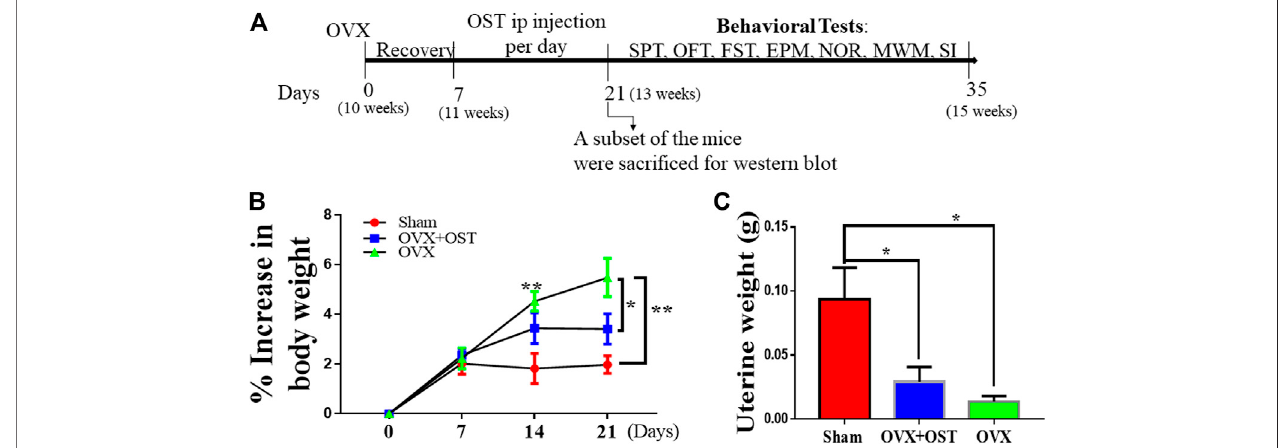
( Figure 2E , p (cid:1) 0.03) and had fewer entries into the arms ( Figure 2F , p (cid:1) 0.001) compared with mice in the sham group. Mice in the OVX + OST group spent more time in the open arms than the OVX group ( Figure 2E , p (cid:1) 0.03) but OST treatment did not increase the number of entries into the open arms in OVX + OST group compared with OVX group ( Figure 2F , p (cid:1) 0.08).